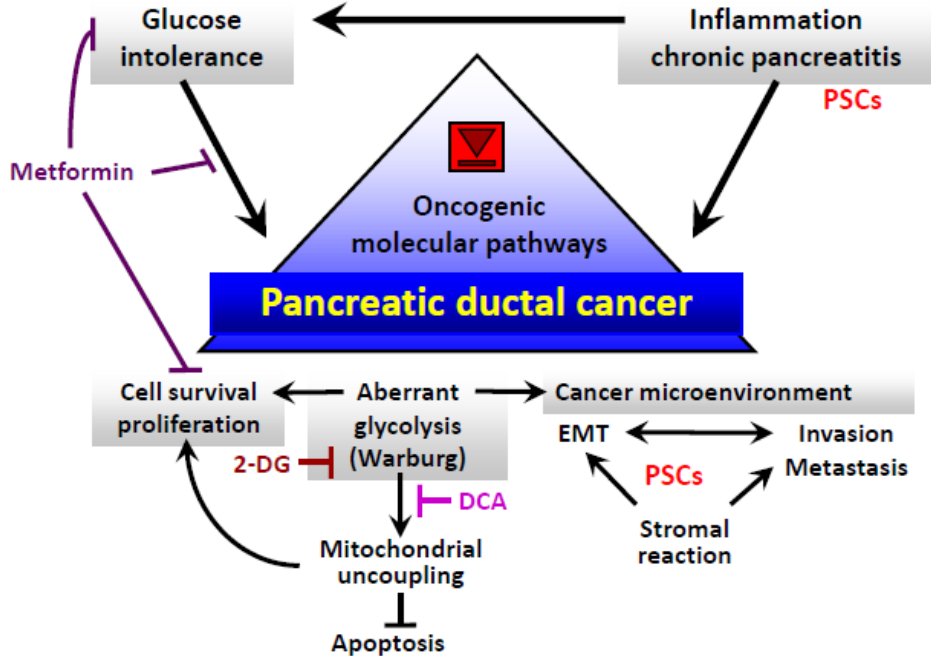
Figure 1. Molecular and biological pathways involved in the development and progression of pancreatic cancer and putative mechanisms underlying the anticancer effects of metformin, 2-deoxyglucose (2-DG), and dichloroacetate (DCA). The gray triangle in a box indicates a molecular target. Abbreviations: EMT, epithelial-to-mesenchymal transition; PSCs, pancreatic stellate cells; Warburg, Warburg